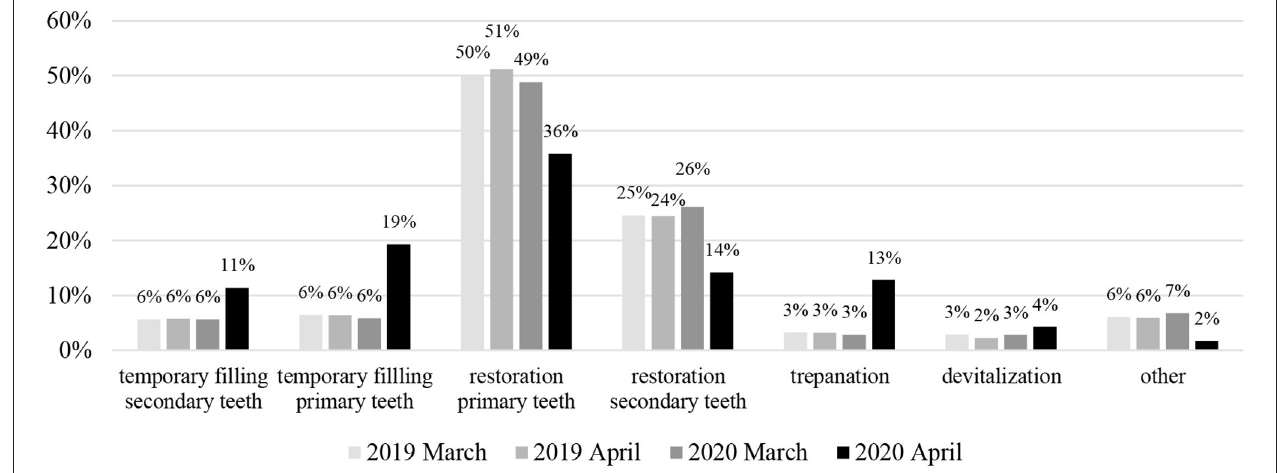
FIGURE 2 | The Statistical comparison showing the percentage of dental service procedures for conservative dentistry (primary and secondary dentition) performed in March and April 2019 and 2020